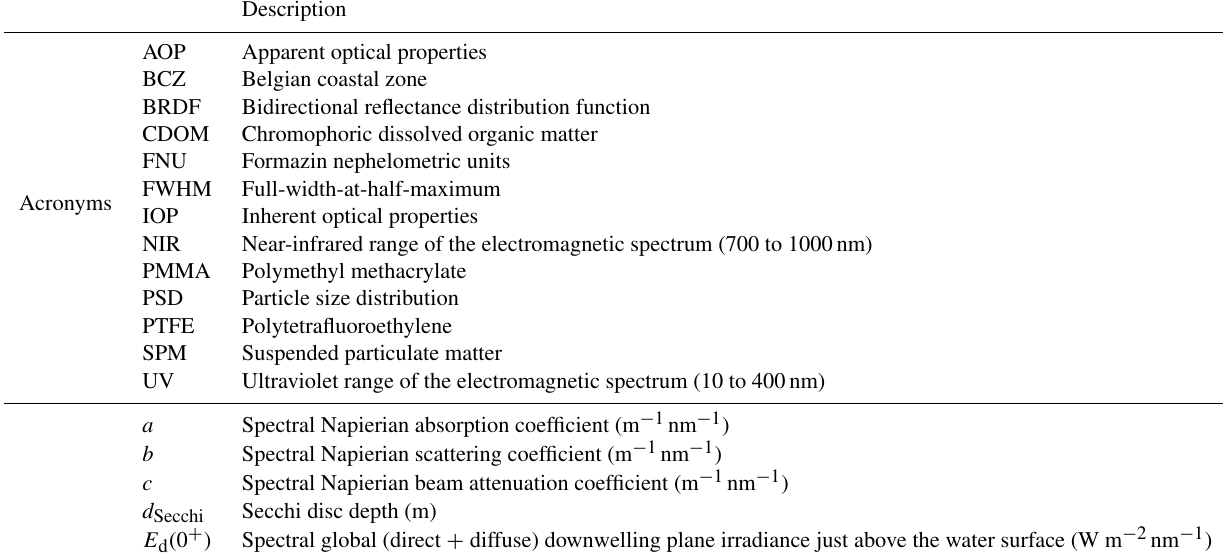
Table 1. Description of relevant acronyms, symbols, constants, and subscripts used in this